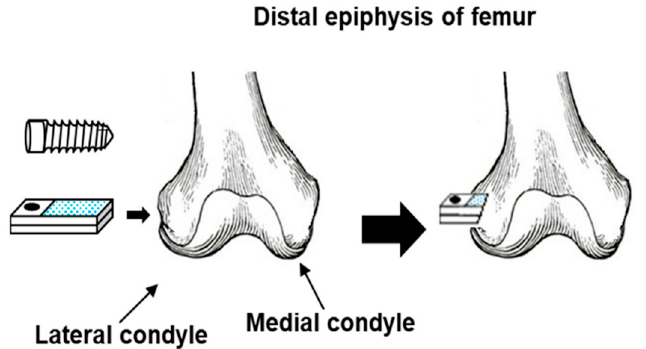
Figure 15. Illustration in diagrammatic form of rabbits’ femurs after implantation. Reprinted with permission from [72]. Copyright 2021 MDPI. Distributed under Creative Commons Attribution-based license (CCBY 4.0.).